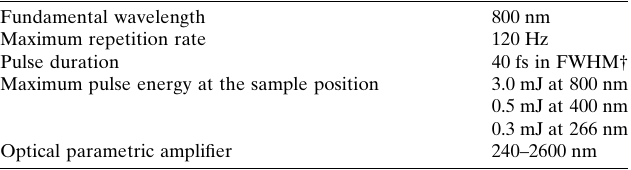
Table 3 Summary of key parameters of the pump laser system – the femtosecond optical